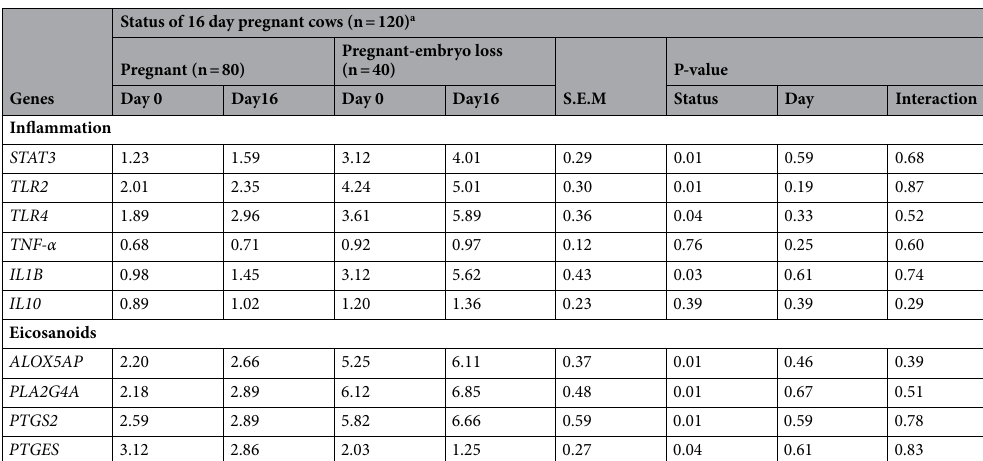
Table 1. Effects of pregnancy status (pregnant or pregnant-embryo loss) on mRNA expression (log-2 scale) of genes related with inflammation response and eicosanoids in polymorphonuclear leukocytes at d 0 (TAI) and d16 after TAI. a Prediction of pregnancy status on d 16 after TAI was determined by ISG15 mRNA gene expression relative to b actin and at day 32 and day 60 after TAI as determined by transrectal ultrasonography. All cows were classified healthy. A cow was pregnant when diagnosed pregnant at 16, 32 and 60 days after TAI respectively. Cows were classified pregnant-embryo loss diagnosed pregnant at 16 days after TAI, but not pregnant at day 32 after TAI (n = 34) or pregnant at 32 days after TAI, but not pregnant at d 60 after TAI (n =